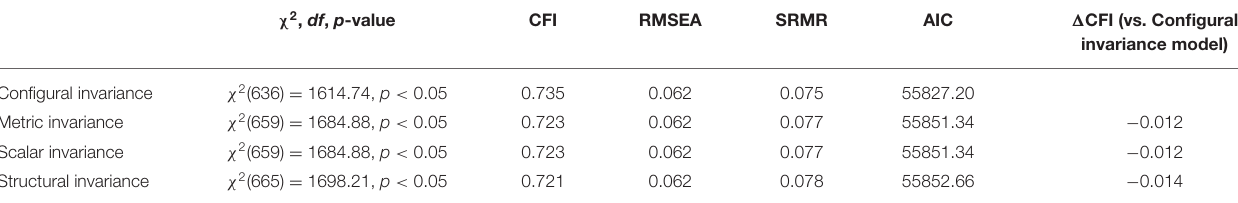
invariance model)